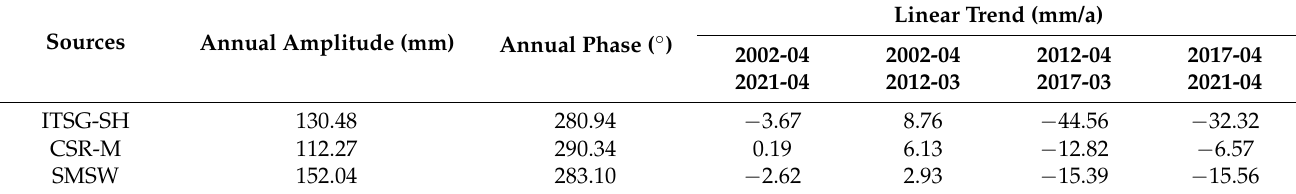
Table 1. Harmonic analysis of TWSC